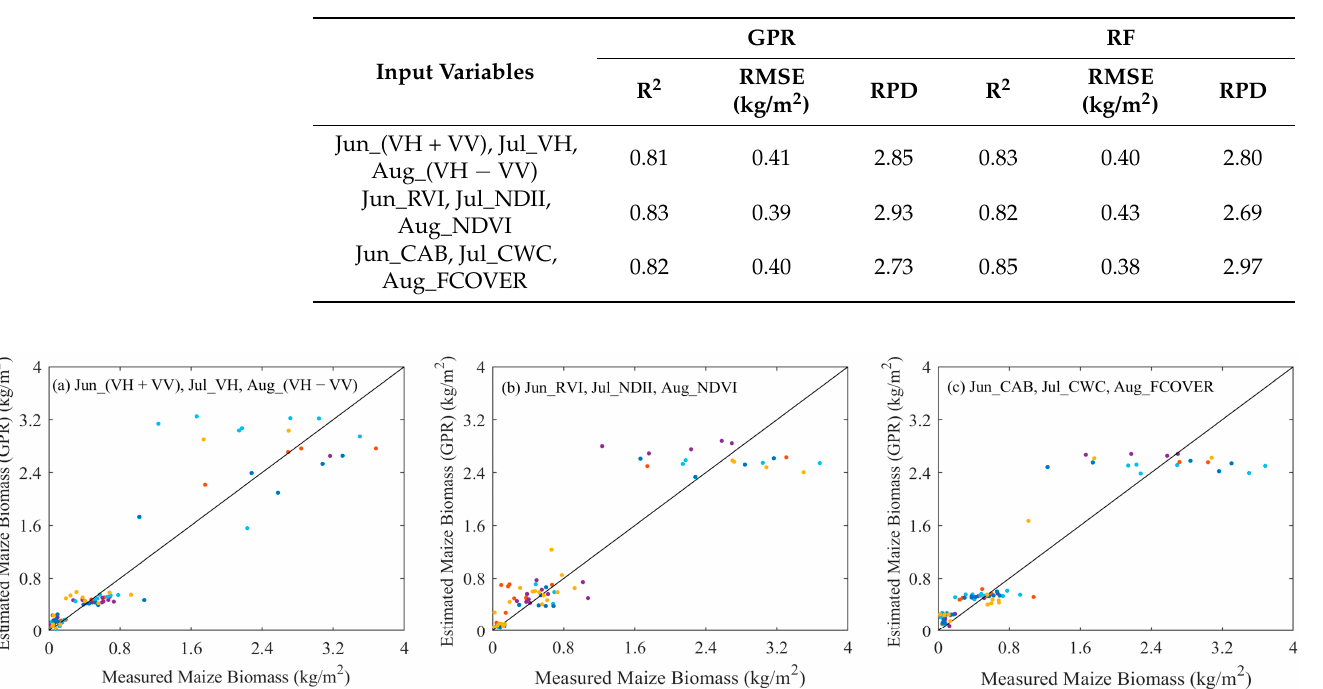
Table 8. Performance of GPR and RF on estimating maize biomass using combined features selected from correlation analysis.